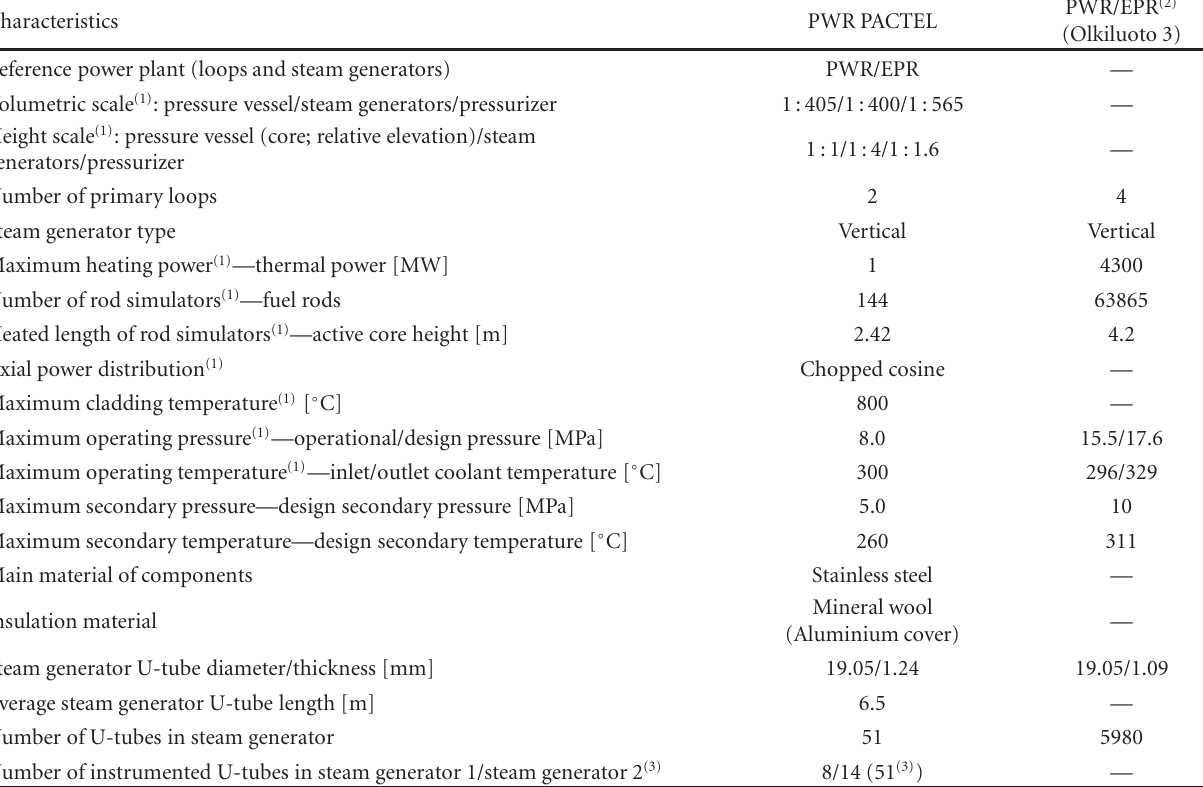
Table 3: PWR PACTEL